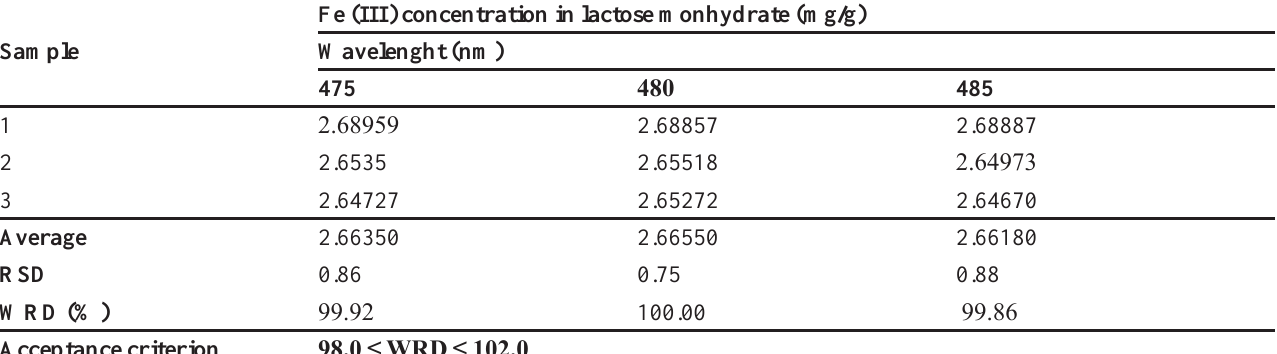
TABLE VIII - Results of the robustness of the procedure in relation to the wavelength. (HCl 0.6 mol/L)